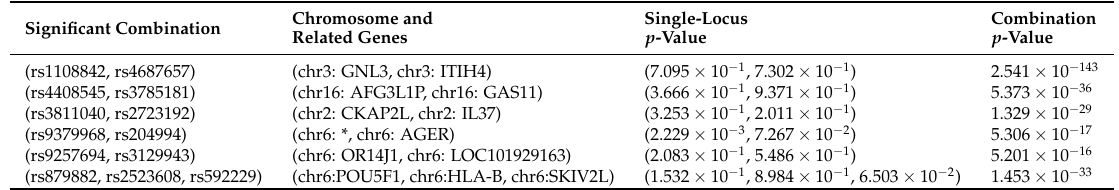
Table 2. Significant two-locus and three-locus combinations identified by HiSeeker on WTCCC BC data. Significant Combination Chromosome and Single-Locus Combination Related Genes p -Value p -Value (rs1108842, rs4687657) (chr3: GNL3, chr3: ITIH4) (7.095 × 10 − 1 , 7.302 × 10 − 1